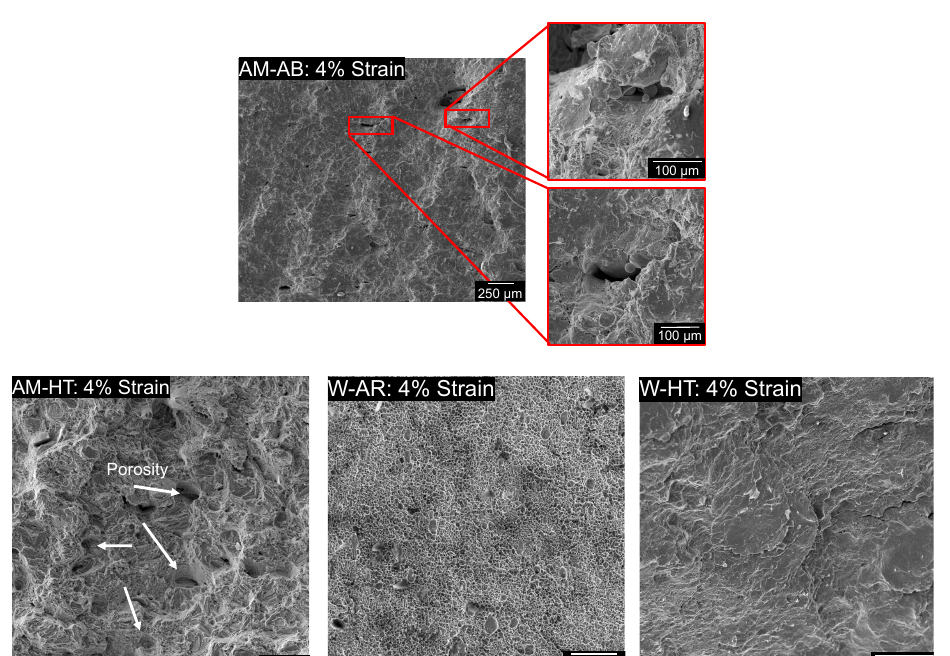
Figure 9. Fracture surface of sample subjected to fatigue testing at 4% strain.